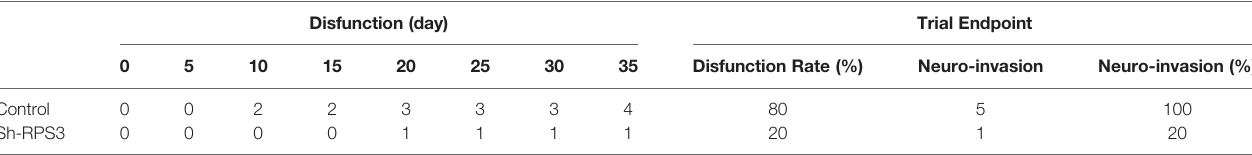
TABLE 4 | ACC invasion of sciatic nerve and hindlimb motor dysfunction after RPS3 knockdown. Disfunction